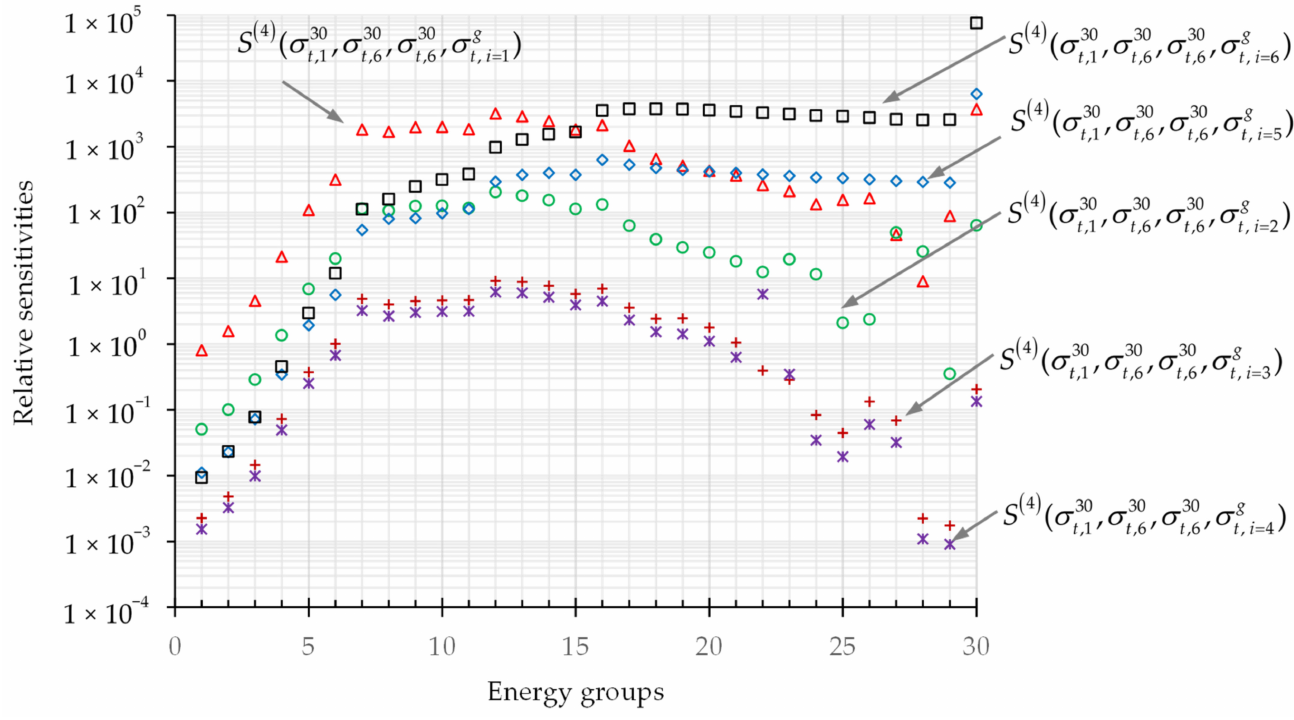
(cid:17) (cid:16) σ 30 , σ 30 , σ 30 , σ g , i = 1, . . . ,6; g = 1, . . . t ,6 t ,6 t ,1 t , i